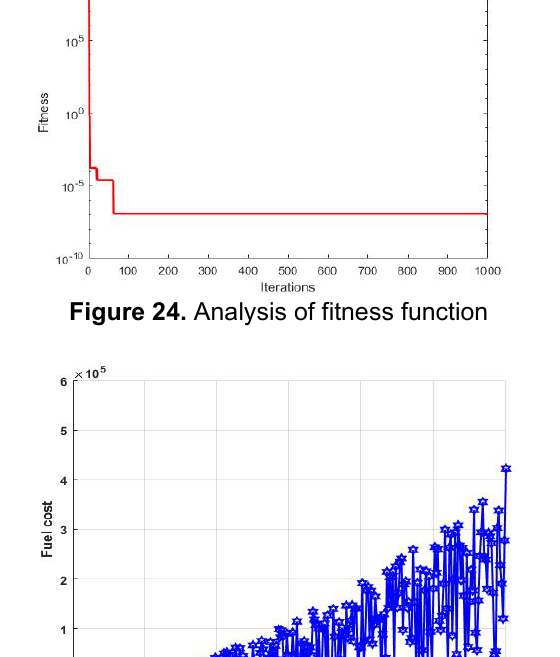
Figure 25. Analysis of Fuel cost